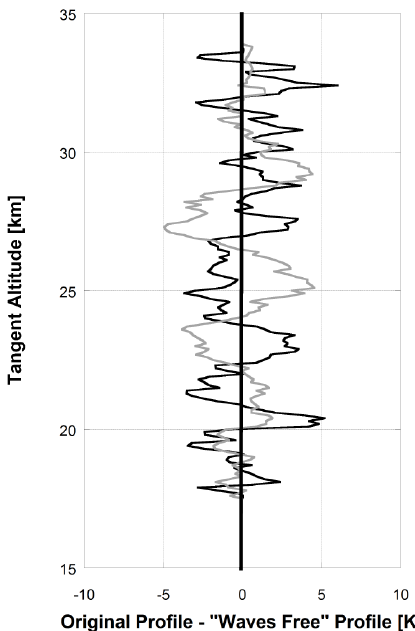
Figure 5. GOMOS HRTP temperature (black line) and neutral den- sity (grey line) percentage perturbation profiles, obtained from the temperature profiles illustrated in Figure 2.